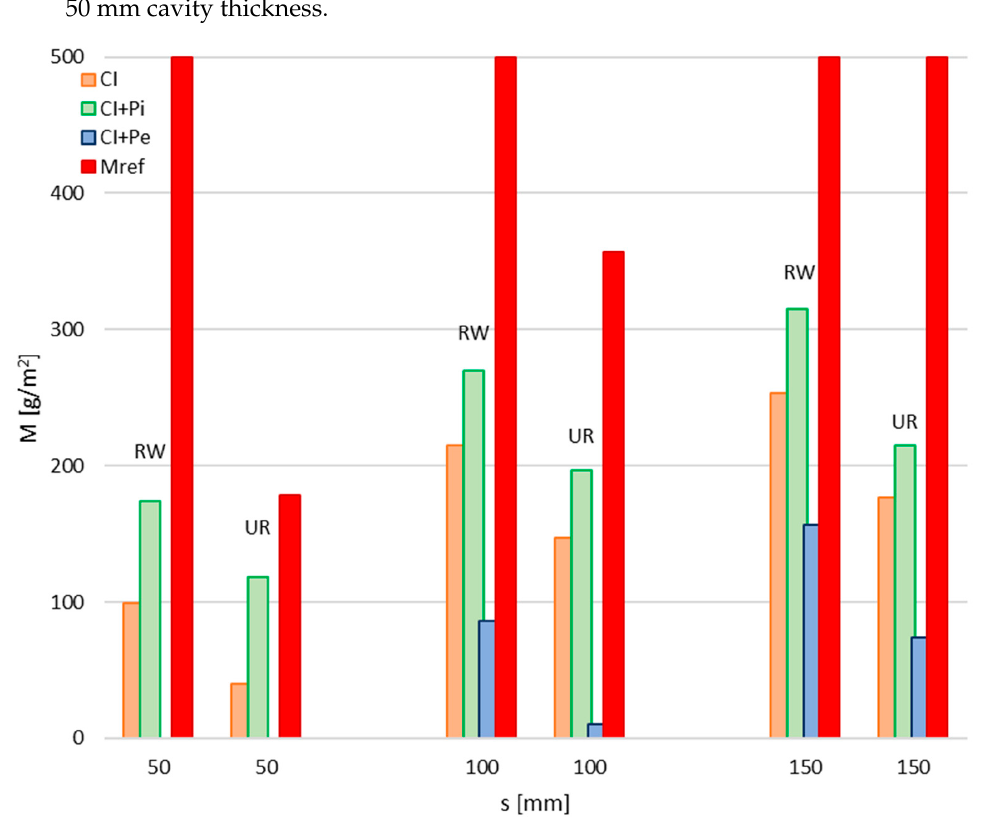
Figure 8. Maximum accumulated condensate M in the cold season (for Air Cavity and SP the results are always 0 g/m 2 ).